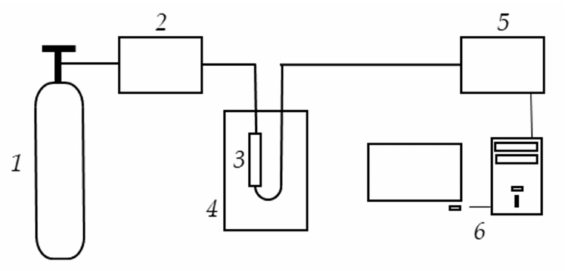
Figure 7. The laboratory setup diagram: 1 —-cylinder; 2 —-gas-flow-rate controller; 3 —-reactor with the catalyst; 4 —-furnace; 5 —-FT-801 Fourier transform IR spectrometer; 6 —-data-processing